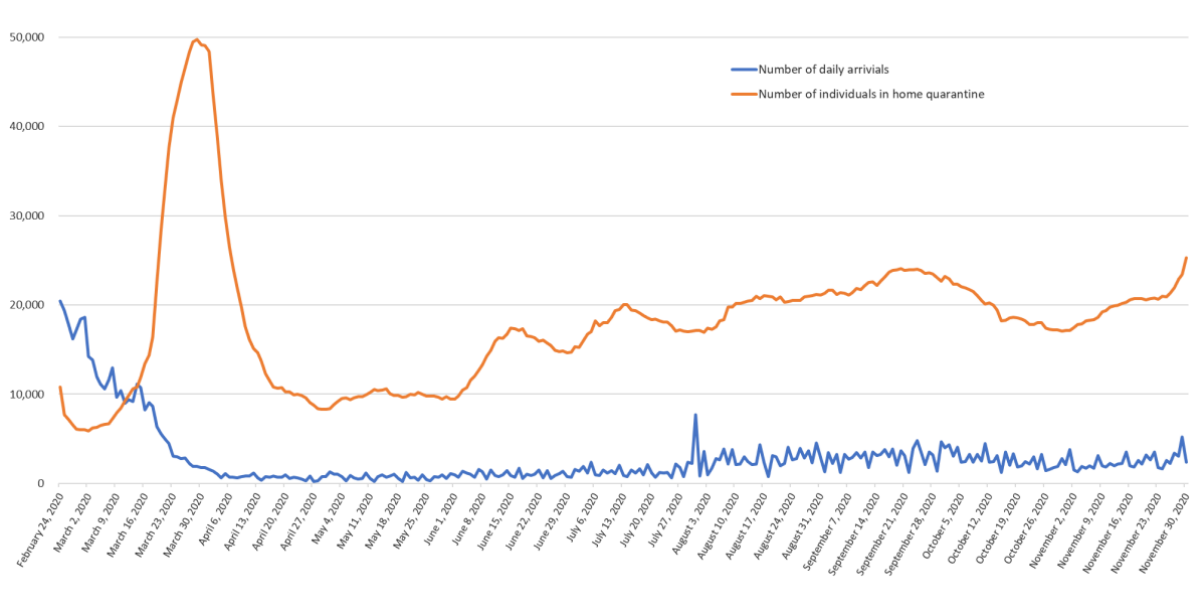
Figure 4. Number of daily arrivals and home quarantine management in Taiwan (data were collected until November 30, 2020).